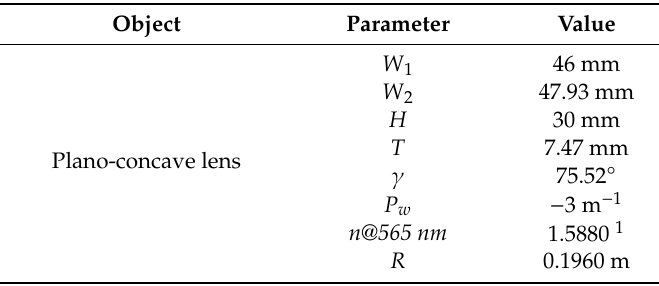
Table 1. Parameters for the plano-concave